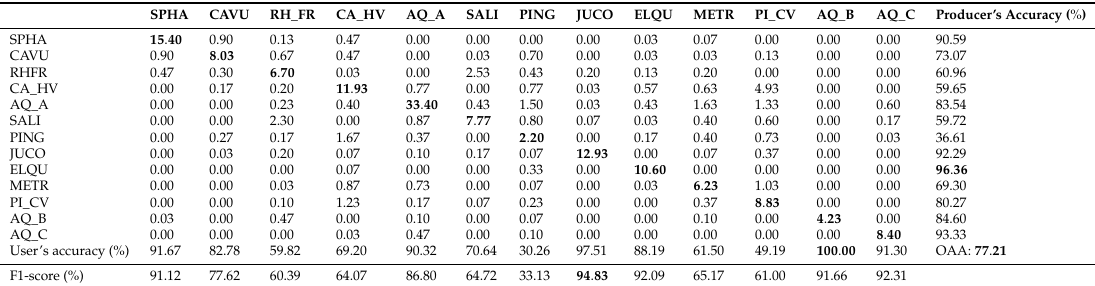
Table 16. Confusion matrix of the classification based on RLR- (cid:96) 2 with indices selected by the Hellinger distance and training size = 25%. The producer’s and user’s accuracies and the overall accuracy average (OAA) are also shown.